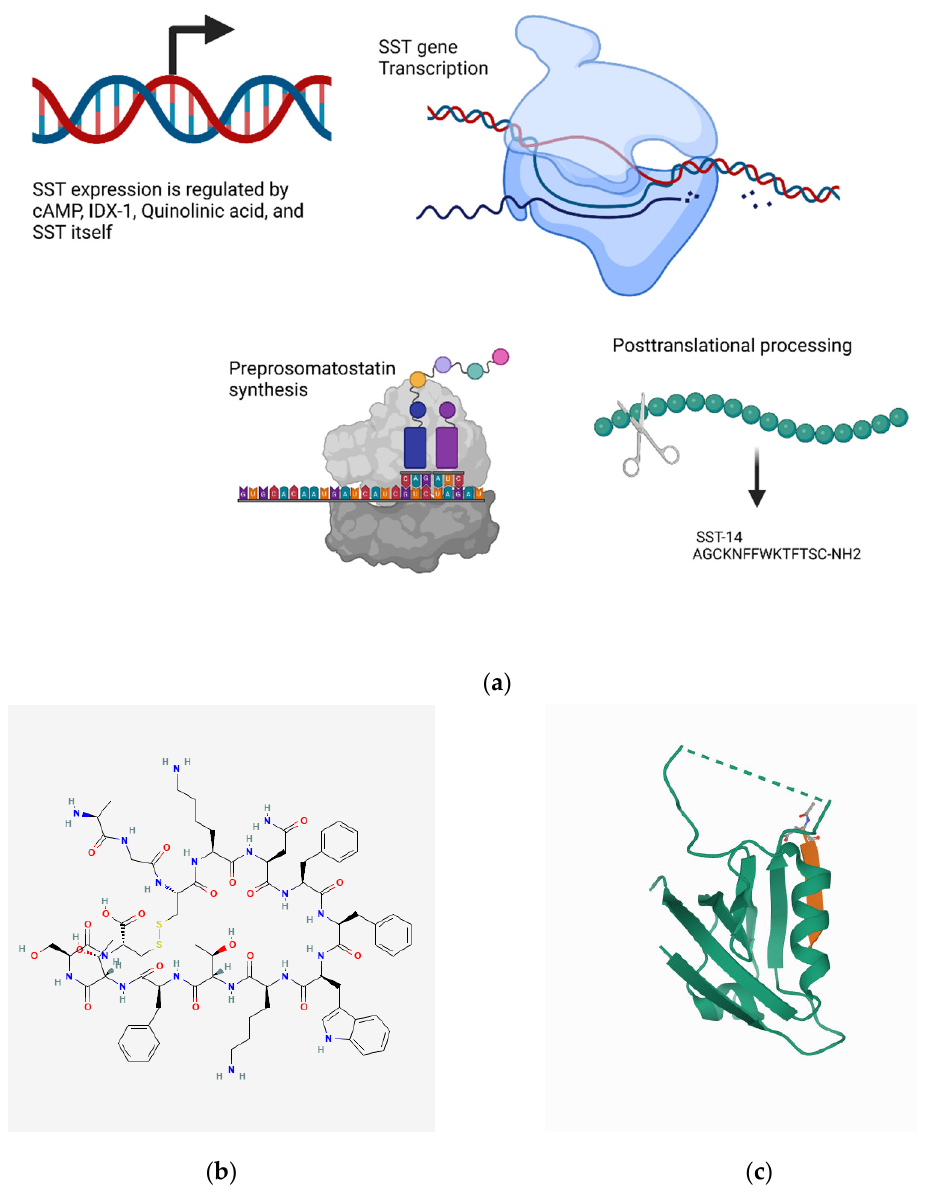
Figure 8. Neuropeptide SST and receptor: ( a ) transcription and synthesis of SST (created with BioRender.com accessed on 22 October 2021); ( b ) 2D structure image of SST (https://pubchem.ncbi.nlm.nih.gov/compound/16129706#section=2D-Structure, accessed on 22 October 2021); ( c ) PDZ domain from rat Shank3 bound to the C terminus of somatostatin receptor subtype 2. Image from the RCSB PDB (rcsb.org) of PDB ID 6EXJ [482].